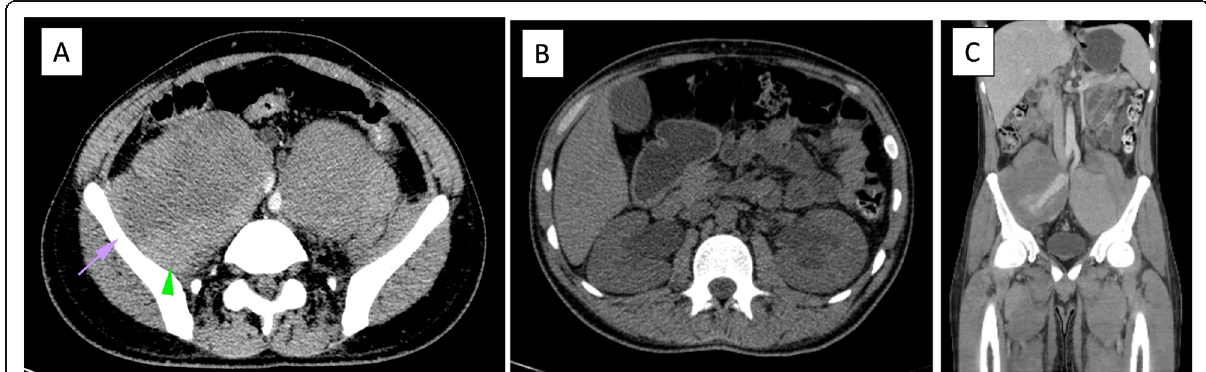
Fig. 1 Contrast-enhanced CT scan of the abdomen and pelvis. Axial view showing bilateral large-diameter pseudoaneurysms of the external iliac arteries; A the arrowhead shows a pelvic hematoma with increased attenuation and the arrow shows a draping effect on the posterior external iliac wall. B axial view, demonstrating bilateral ureterohydronephrosis; C Coronal view, in which leakage of contrast is seen in the right side